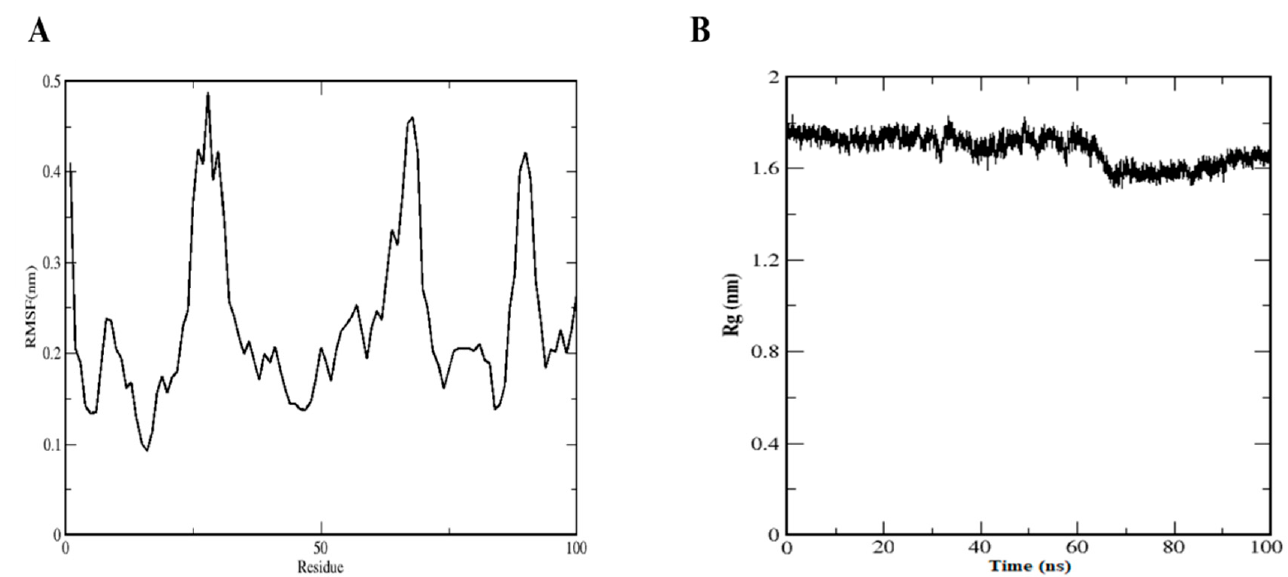
Figure 3. ( A ) Root-mean-square fluctuation of the DTQ–MSTN complex. ( B ) Radius of gyration of DTQ–MSTN complex. H-bond number is directly related to complex stability (Figure 4A). Five H-bonds were formed during the simulation time, though two H-bonds were present constantly throughout the simulation. Solvent accessible surface area (SASA) is used to determine the solvent accessibility of proteins. The SASA graph showed the same pattern as the gy- ration radius (Figure 3B), which was initially large (78 nm 2 ) (Figure 4B).